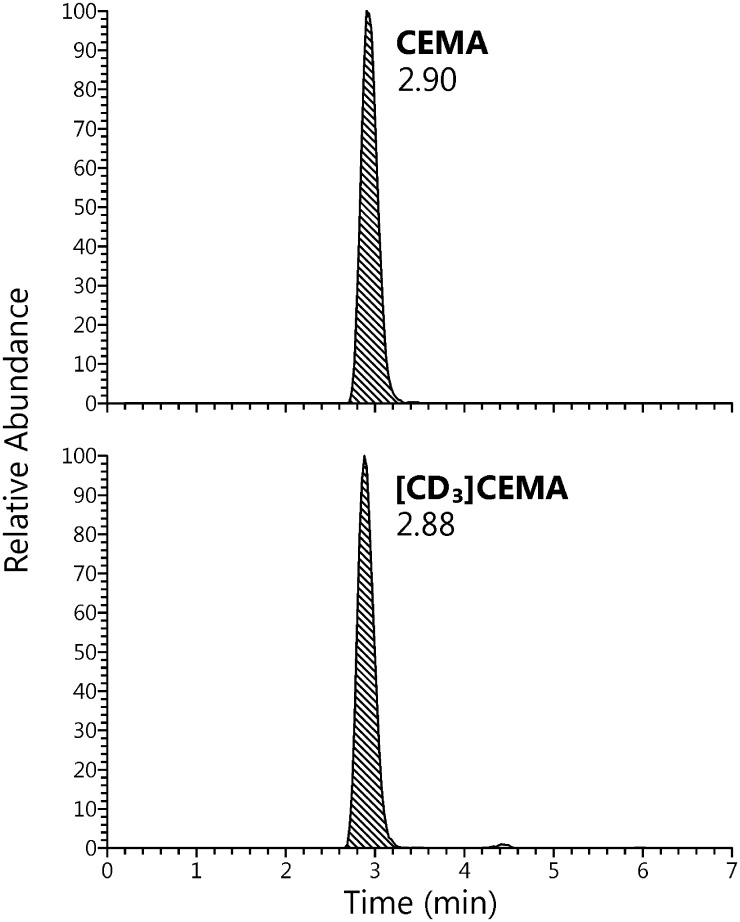
LC-MS/MS chromatograms of CEMA and the internal standard [CD3]CEMA.